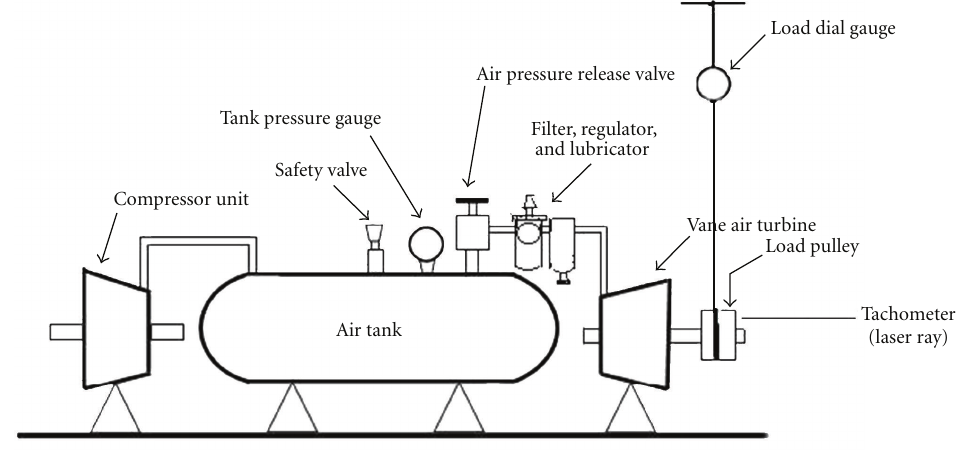
Figure 8: Schematic test setup.